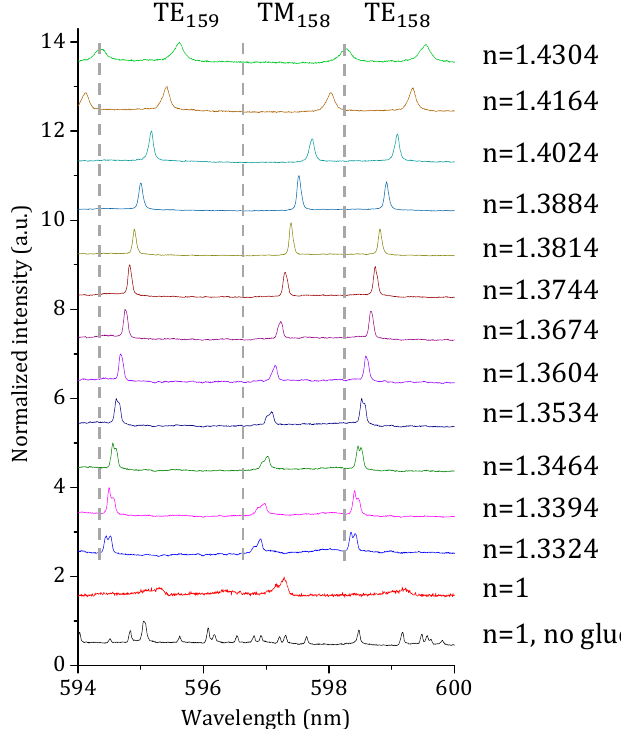
Figure 2. Normalized spectra of a single microsphere subjected to different environmental conditions. The different spectra were offset to highlight the resonance shift and Q-factor behavior. The black line indicates the fluorescence whispering gallery mode (WGM) spectrum of the sensing sphere before it was partially immersed in glue. The remaining spectra were taken in air and a range of liquids after the sphere was attached to the end of the Microstructured optical fiber (MOF) and partially covered by the glue.